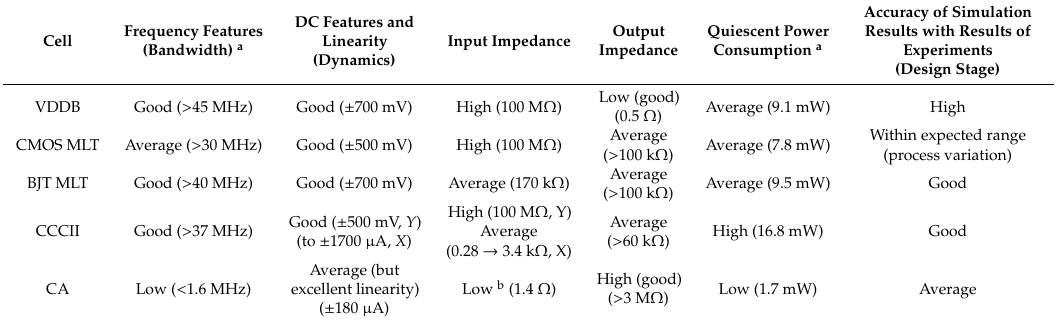
Table 3. Brief comparison of the selected important measured features of the proposed cells included in the IC.